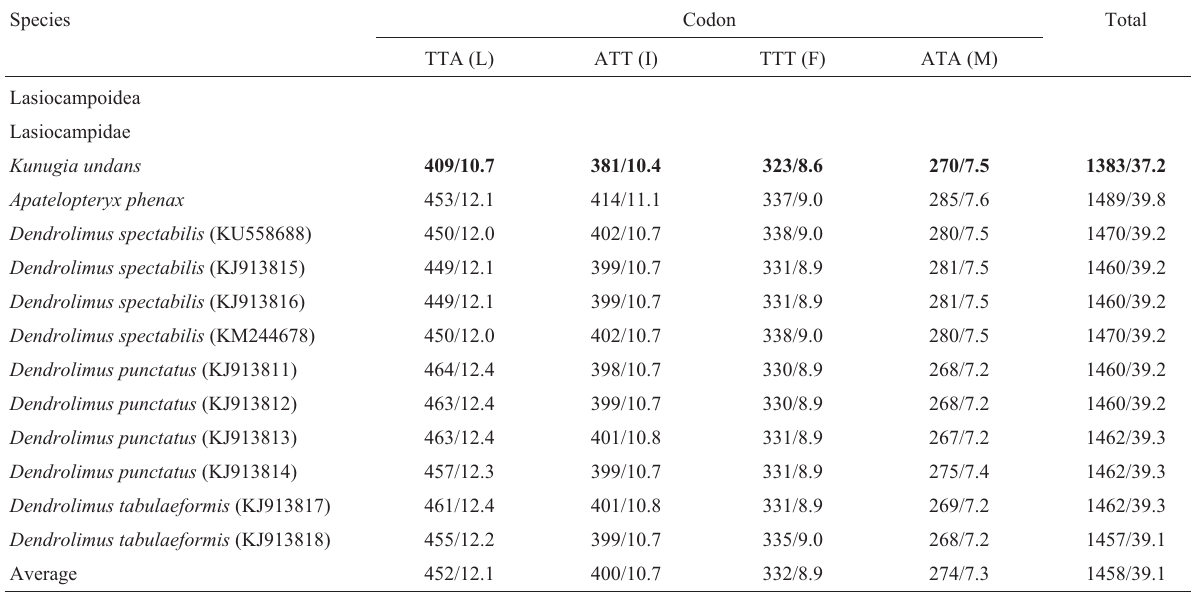
Table 3 - Frequency of the four most frequently used codons in